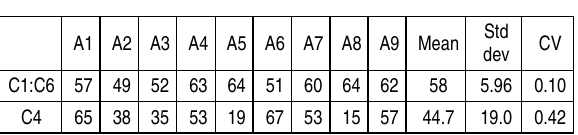
Table 46. Performances of consortium C1:C6 and